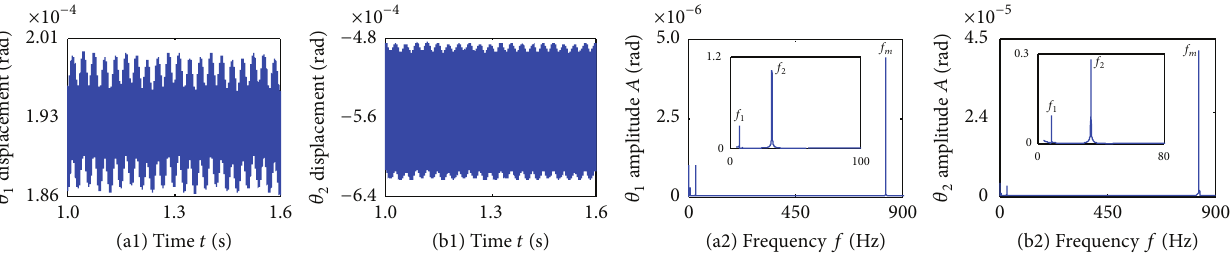
Figure 5: Torsional waveform and frequency spectrum at 𝑛 1 = 500 r/min, 𝜌 1 = 2.0 × 1 0 −6 m, and 𝜌 2 = 2.0 × 1 0 −5 m. ×10 −7